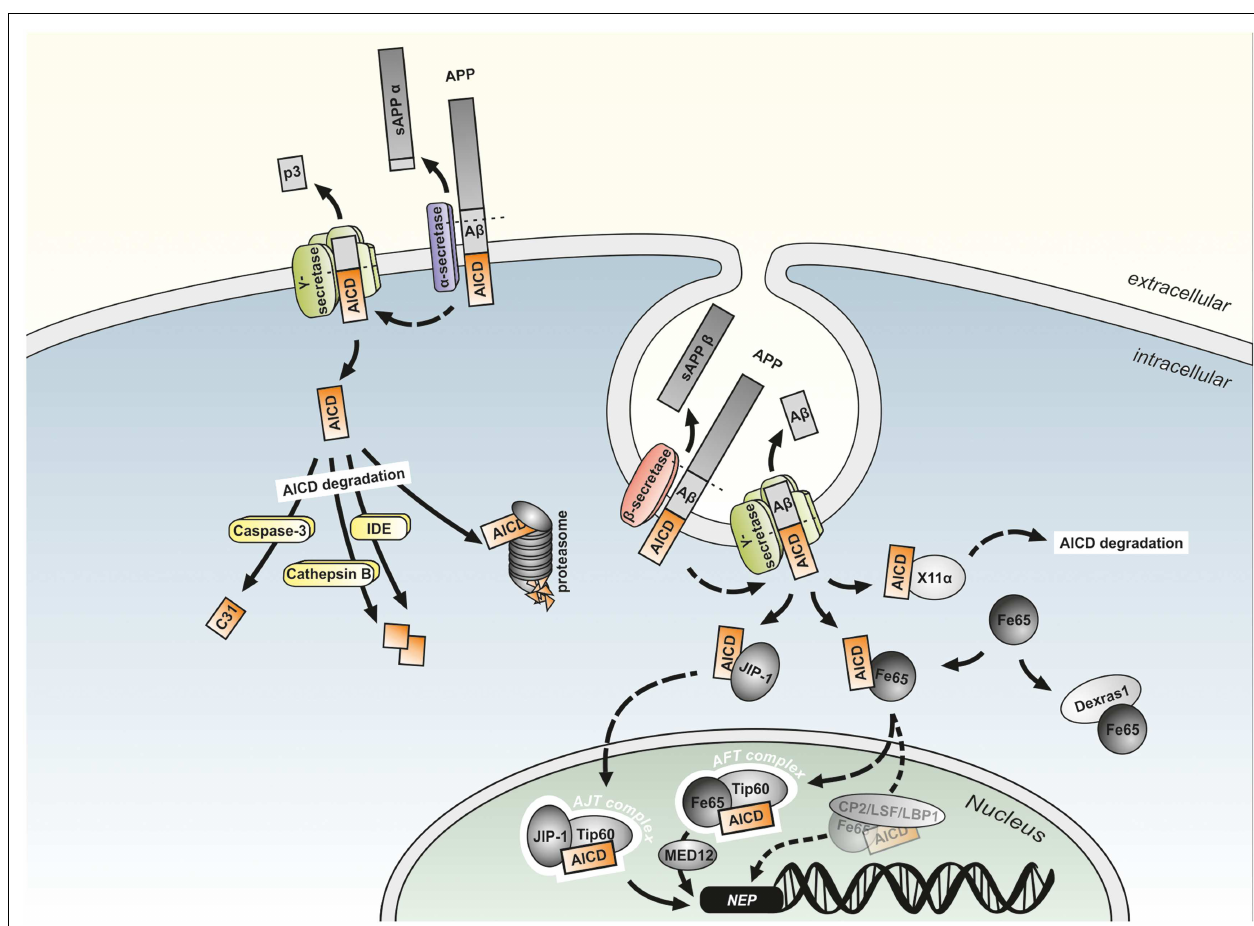
processing can be stabilized by binding to Fe65 or JIP-1 and translocated to the nucleus, where the gene regulatory AFT (AICD, Fe65,Tip60) or AJT (AICD, JIP-1,Tip60) complexes are formed. Alternatively toTip60, the transcription factor CP2/LSF/LBP1 is hypothesized to interact with Fe65 and activate AICD-mediated gene transcription. Binding to the MED12 protein links these complexes to the RNA polymerase transcription apparatus. Additionally binding of AICD to MINT1/X11 α or the interaction of Dexras1 with the PTB2 domain of Fe65 results in an inhibition of Fe65/AICD induced